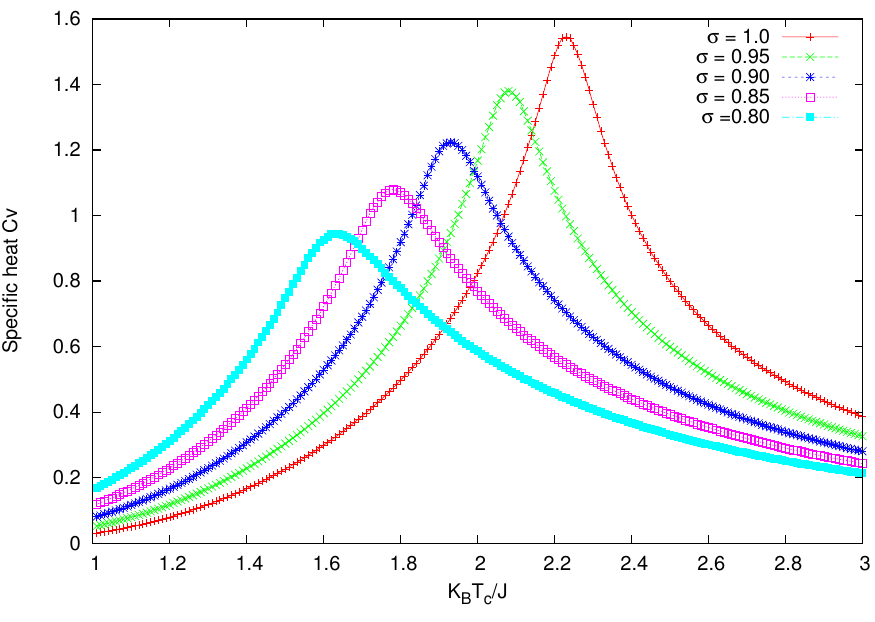
Fig. 2. The specific heat C v as a function of the